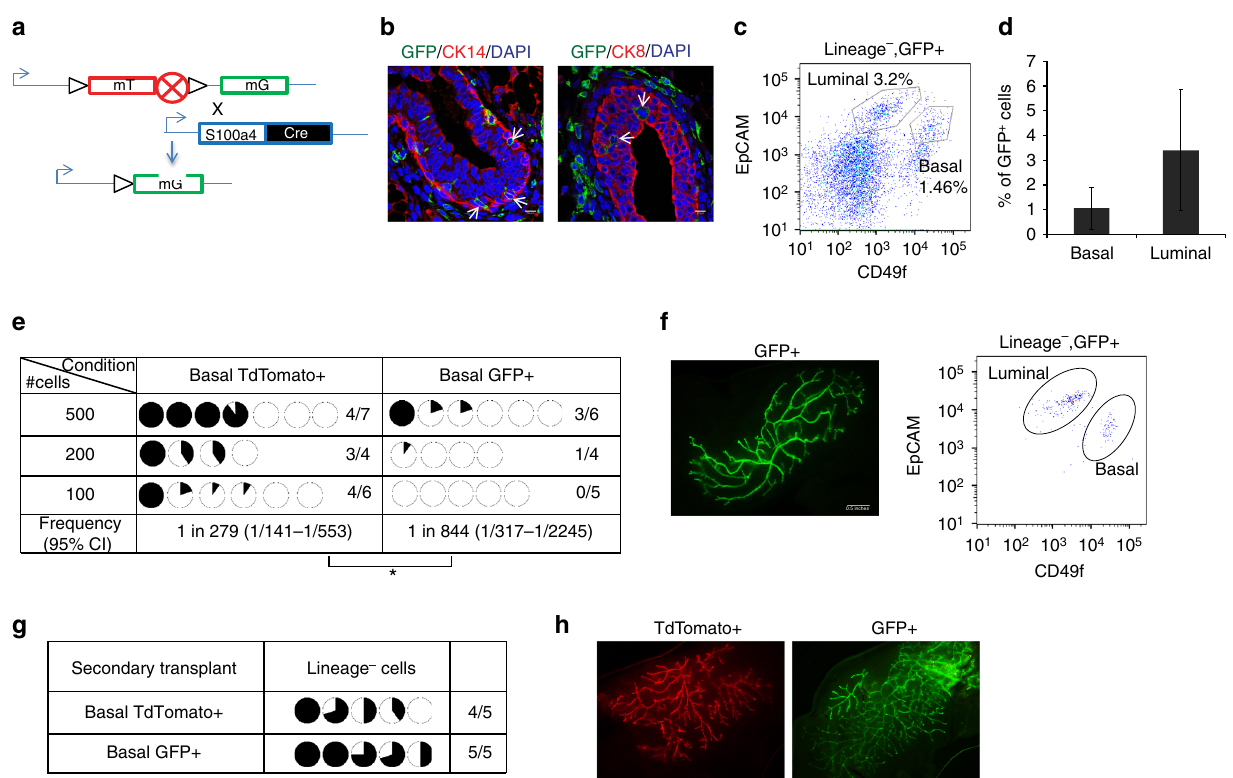
Fig. 2 S100a4 lineage traced basal cells can regenerate the mammary gland in vivo. a Schematic diagram showing the crossing of Rosa26 mTmG reporter with S100a4-cre mice. b Immuno fl uorescence analysis showing that S100a4 lineage traced cells (GFP+) are present in mammary epithelial cells. CK8/CK14 (red), GFP (green), and DAPI (blue). Arrows indicate S100a4 traced epithelial cells. Scale bar, 10 µ m. c Representative FACS analysis of the S100a4 cre / Rosa26 mTmG mouse mammary gland of Lineage − /Live − /GFP+. ( n = 20 mice). Also see Supplementary Fig. 2a. d Percentage of GFP+ cells in basal and luminal cell populations. The data are shown as mean ± SD ( n = 10 mice). e Basal TdTomato+ and GFP+ cells were sorted from 10 – 12-week-nulliparous females and transplanted in 3-week old mice. All transplants were analyzed after 8 weeks. The data are combined from three independent transplantation experiments. Pie charts show the percentage of mammary fat pad fi lled. (* p < 0.05, frequencies and p -value are calculated using ELDA software). Also see Supplementary Fig. 2 a for sorting scheme. f Representative image of a basal GFP+ transplant (left). FACS analysis using EpCAM and CD49f showing basal and luminal cell populations (right) ( n = 3 outgrowths). g Secondary transplant of cells from e . Pie charts show percentage of mammary fat pad fi lled. h Representative image of secondary transplants from TdTomato+ (left) and GFP+ basal cells (right) ( n = 4